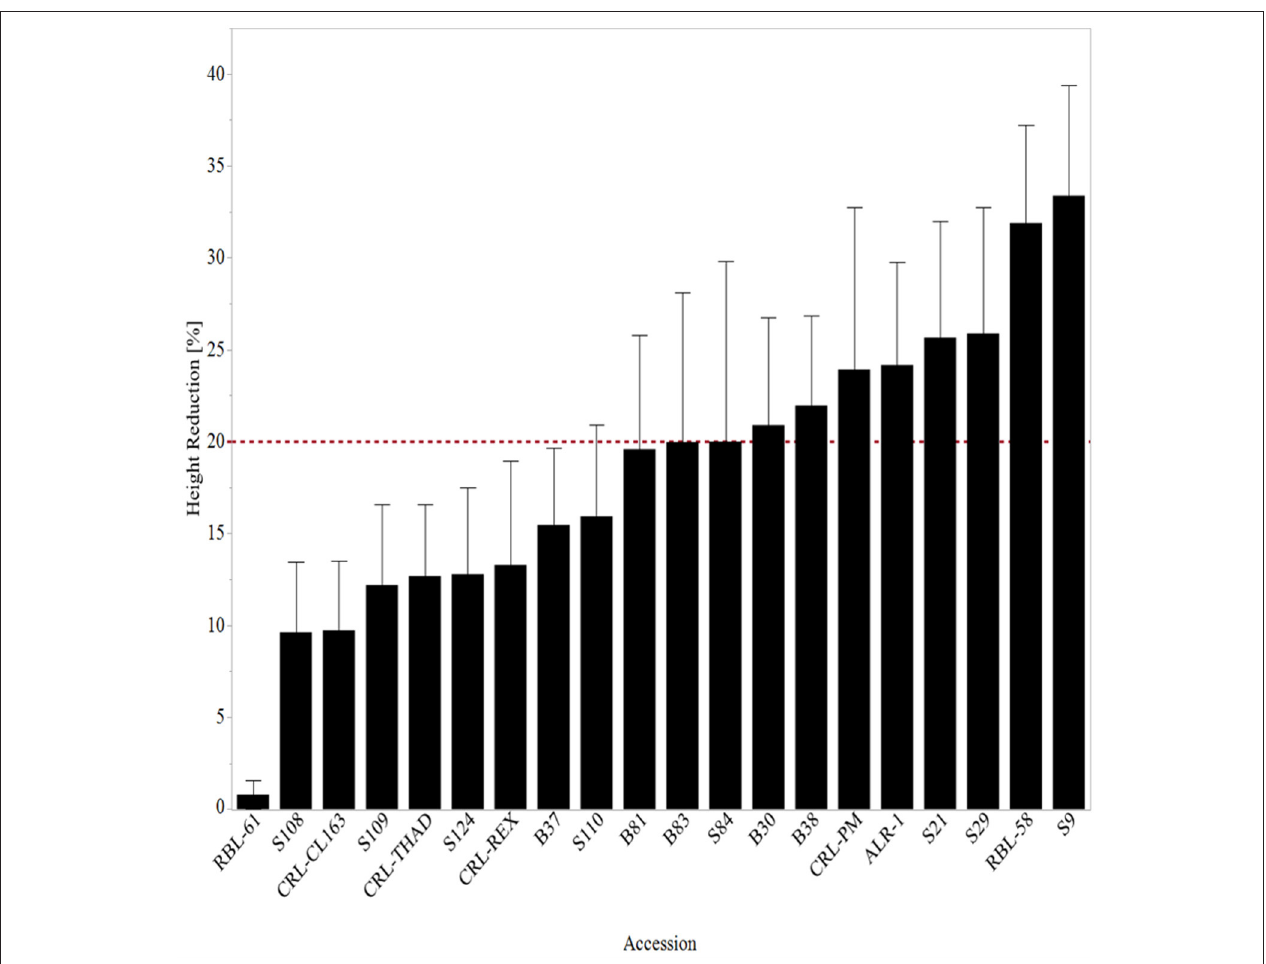
FIGURE 1 | Mean height reduction 14 days after heat stress treatment arranged from lowest reduction to the highest reduction in height. The line at 20% represents all lines with ≥ 20% reduction in height. RBL, Rice breeding line; CRL, cultivated rice line.